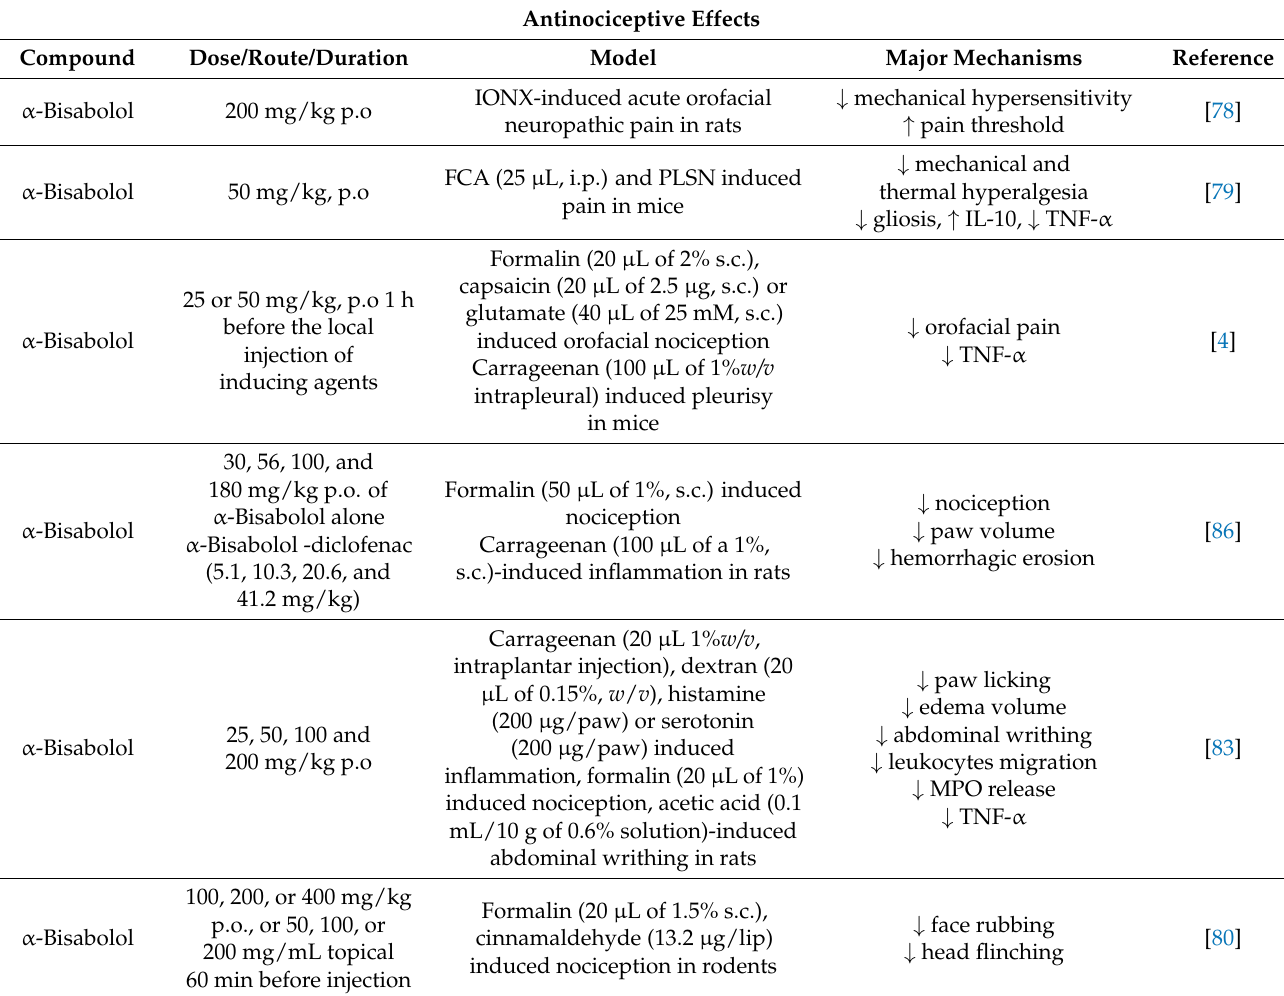
Table 6. The anti-nociceptive actions of α